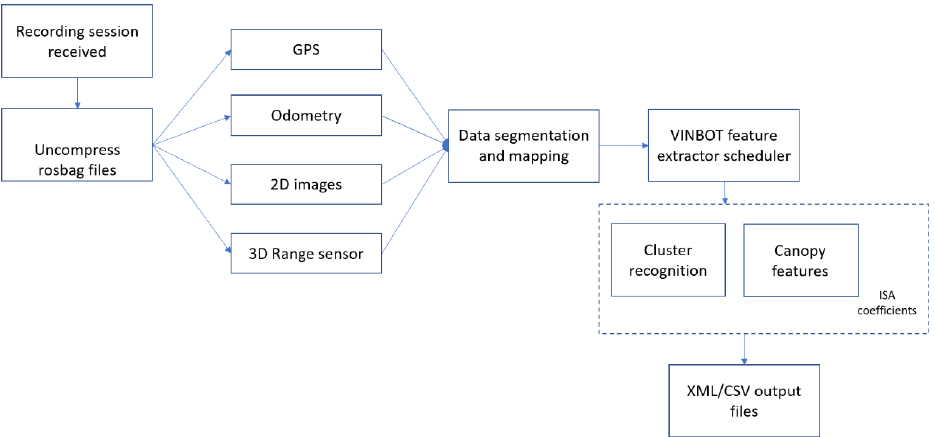
Figure 5. Sensors and components of the VINBOT Platform.